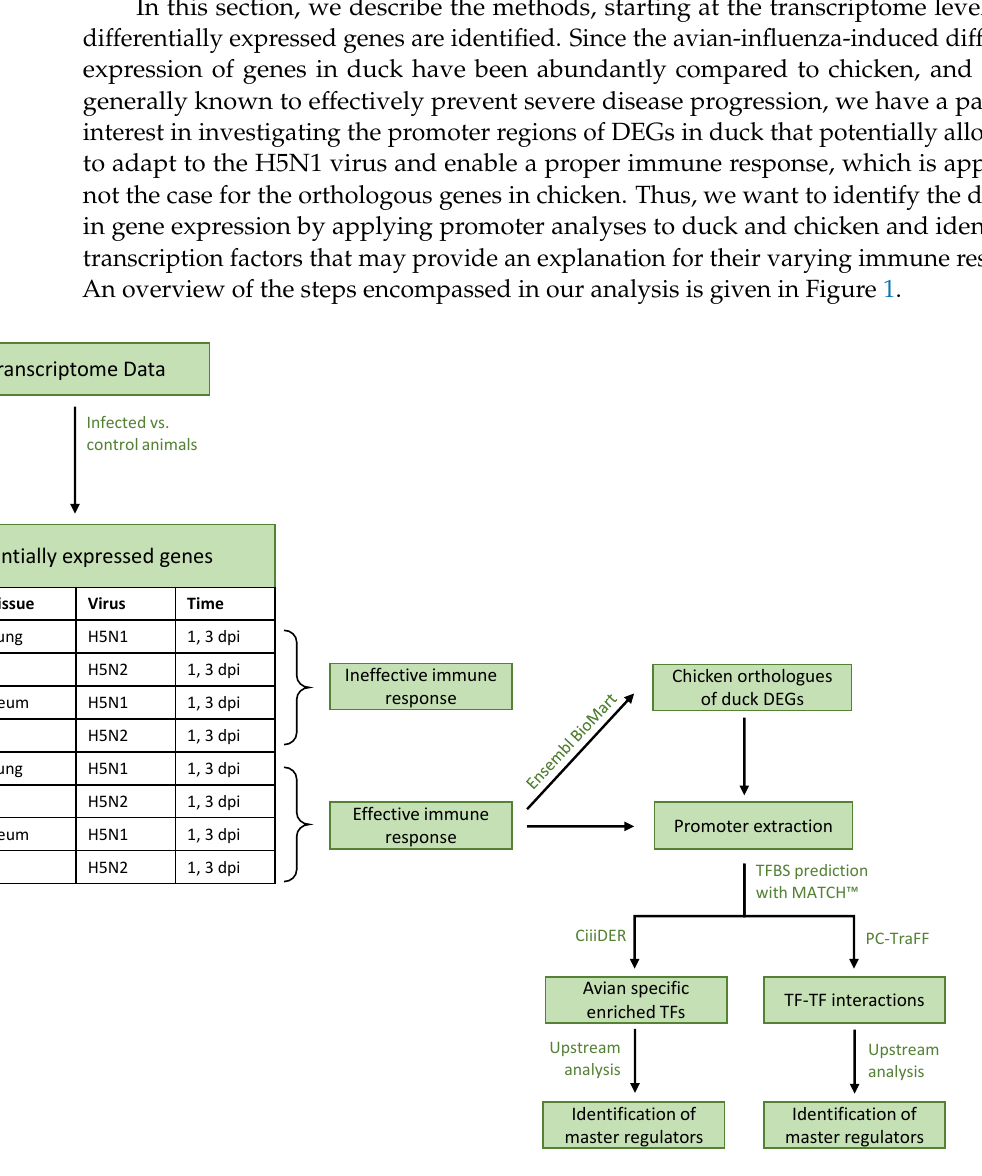
Figure 1. Flow chart of the employed analyses. Differentially expressed genes (DEGs) were derived by comparing the gene expression rate of a specific condition against a mock infection for that condition (e.g., chicken lung at 1 dpi with H5N1 infection against chicken lung at 1 dpi with mock infection). TF and TFBS stand for transcription factor and transcription factor binding site, respectively. H5N1 is a high-pathogenic avian influenza virus (HPAIV), while H5N2 is a low-pathogenic avian influenza virus